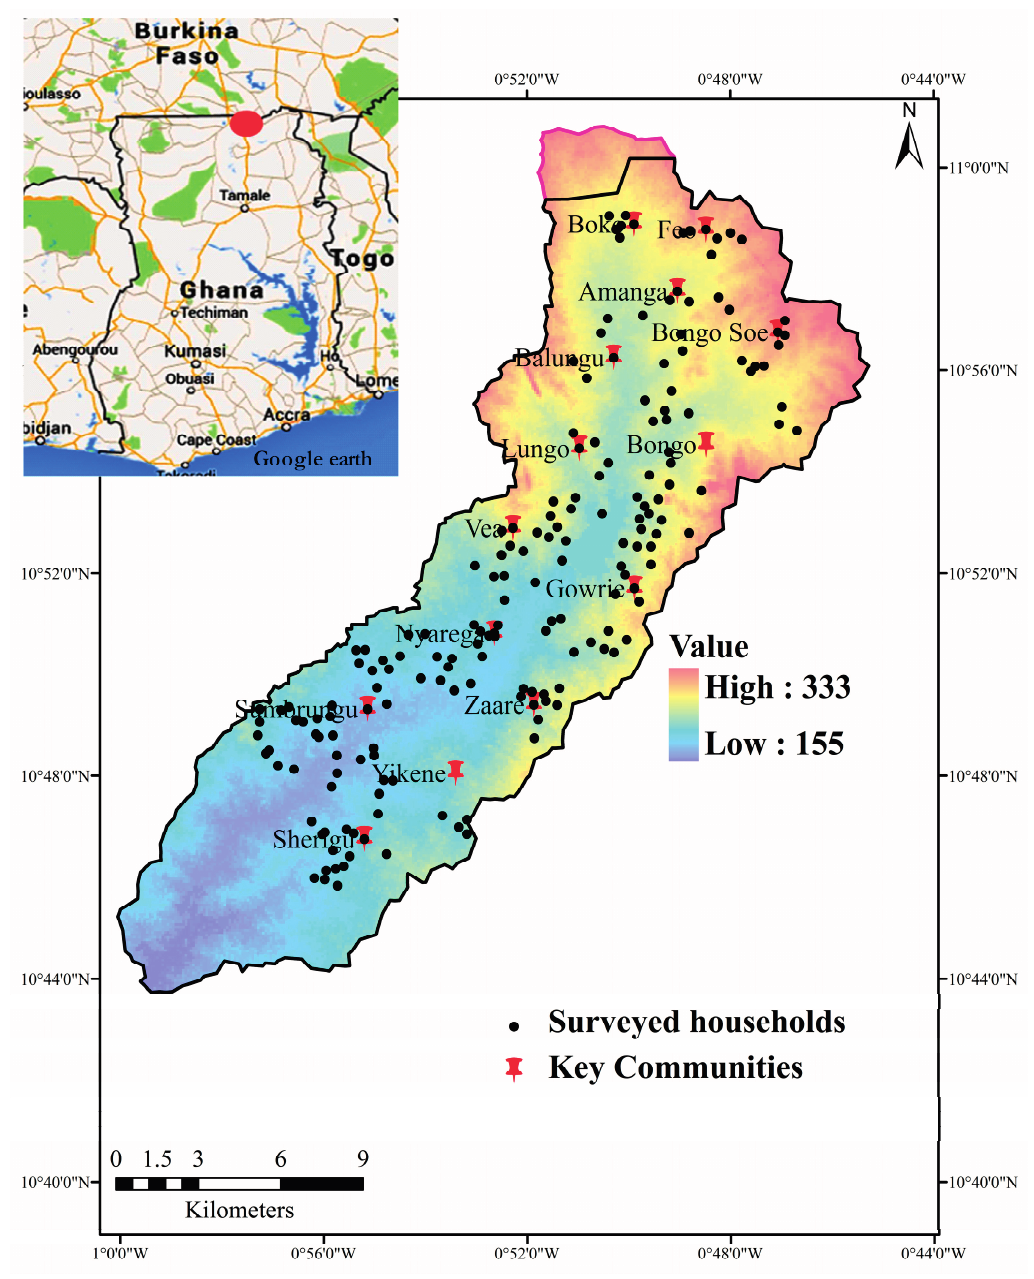
Figure 1. Elevation map of Vea catchment showing the locations of sampled farm households. The upper pink boundary represents the Burkina Faso section of the